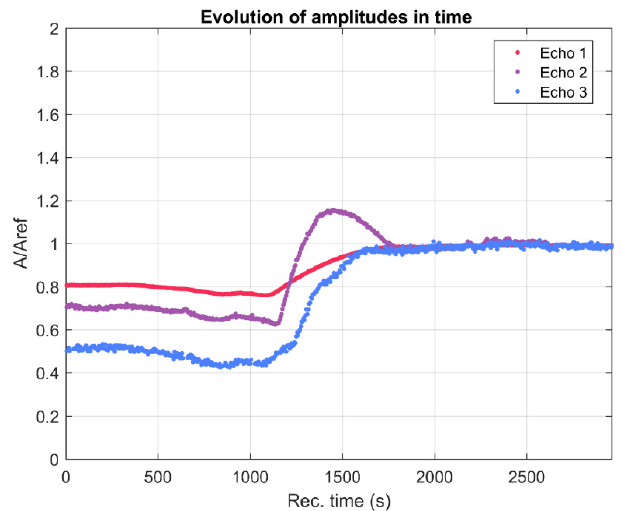
Figure 2. Relative amplitudes evolution vs. the recording moments. Coatings 2019 , 9 , x FOR PEER REVIEW